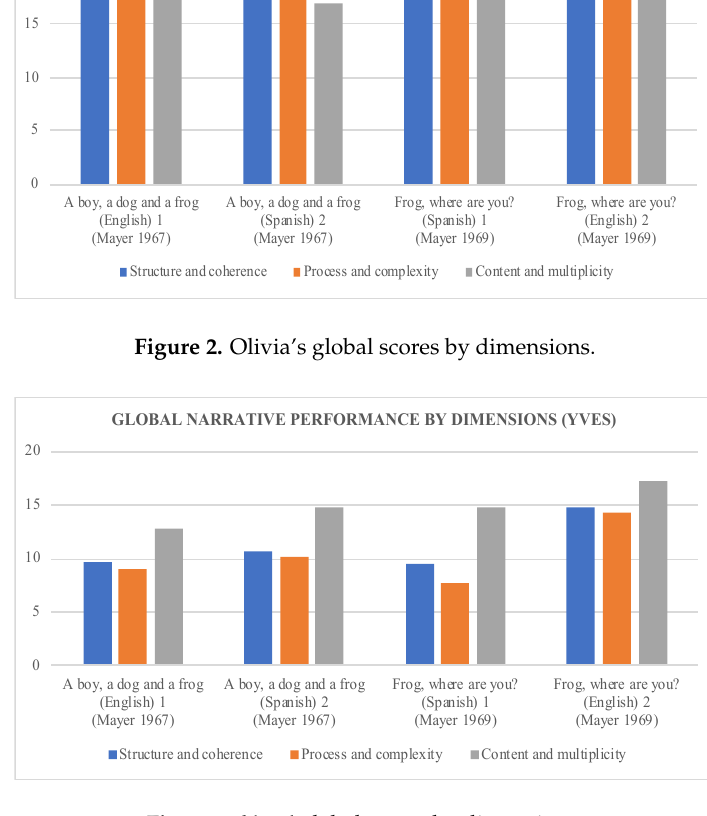
Figure 3. Yves’ global scores by dimensions.